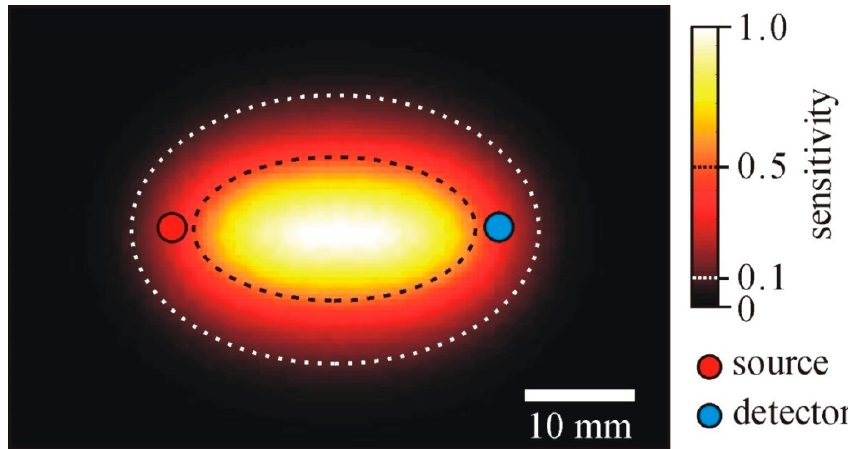
Figure 2. The spatial sensitivity profile on the grey matter surface. The black and white dotted lines indicate 50% and 10% with respect to the maximum sensitivity. This profile was obtained by a Monte Carlo simulation of a five-layered head model. Reproduced with permission from [7] © 2016 Springer.